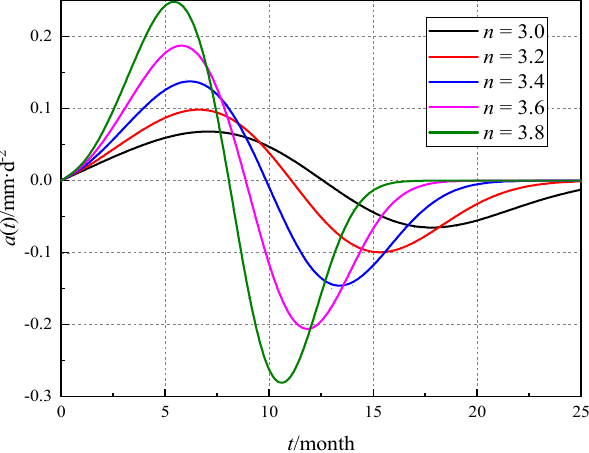
Figure 3. The influence of model order n on surface subsidence velocity.